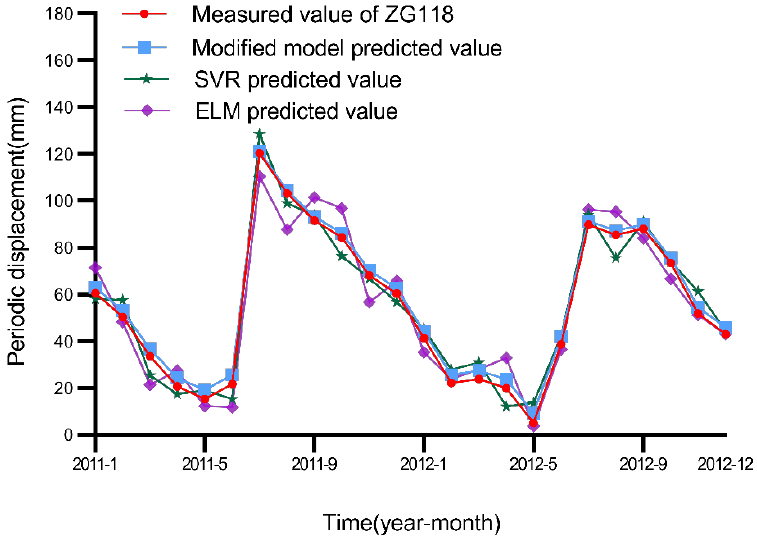
Figure 20. Periodic displacement predicted results of ZG118 using LSTM-FC, SVR and ELM models.